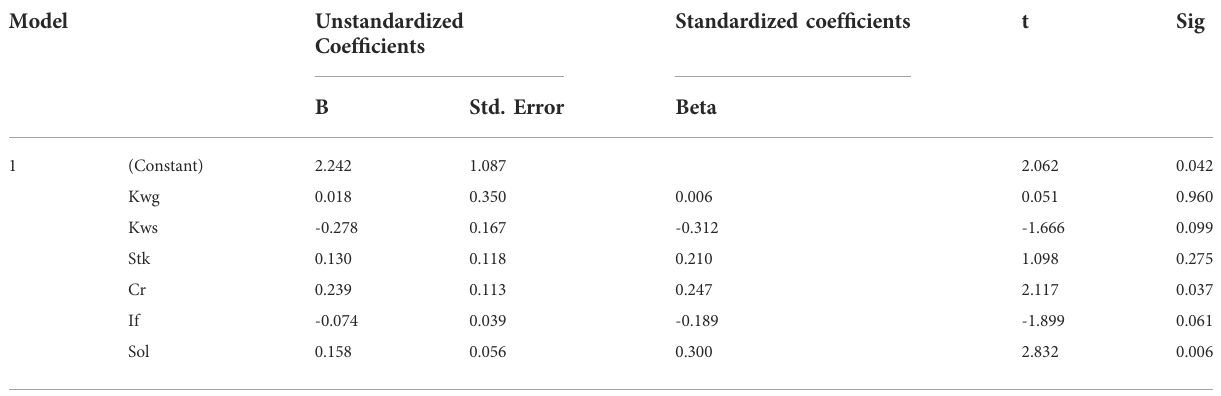
TABLE 10 Coef fi cients of the independent variables corresponding to the variable for